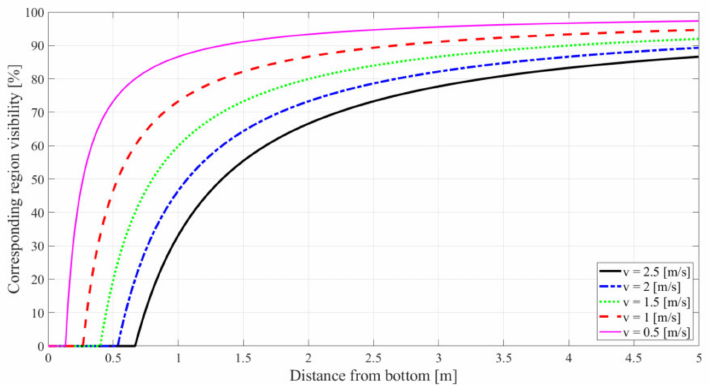
Figure 6. Corresponding region of visibility for different distances from bottom and the vehicle’s velocities. In this case, for the focal length f = 47.5 mm, acquisition rate = 5, and image resolution 768 × 576 pixels, the vehicle should move at a distance of 3 m from the bottom to meet the required 75% correspondence for all speeds. Additionally, taking into consideration the fact that the camera can be mounted at the angle α to the vehicle (see Figure 7), the value of the angle also influences the corresponding region of visibility.